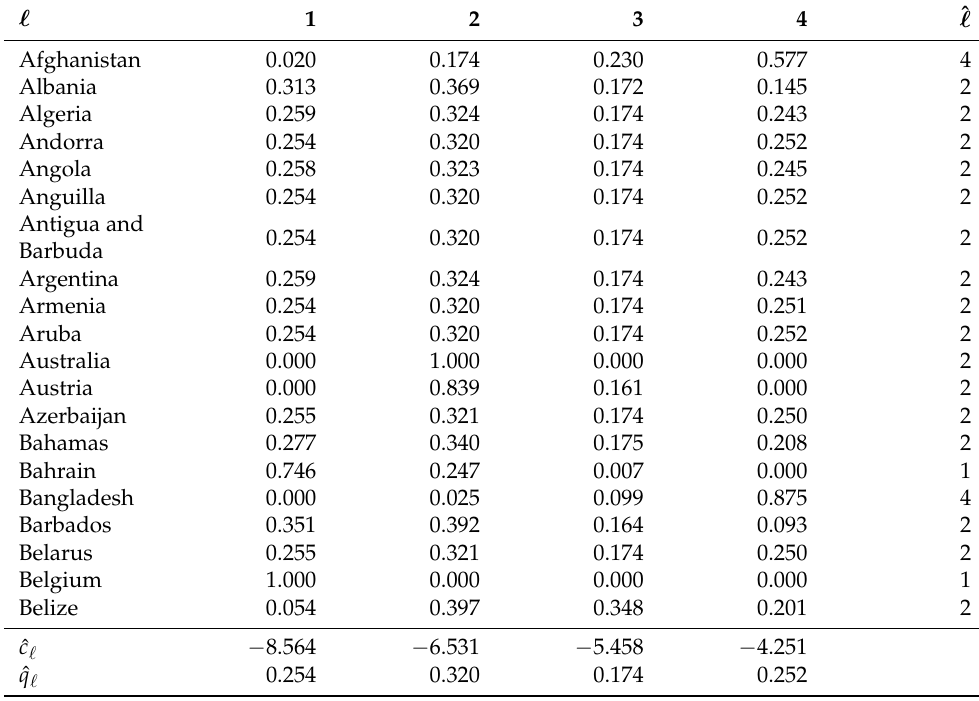
Table 4. Matrix V for data from 21 June 2022 using the 14-day lag, along with MAP classifications (right column) and the associated masses and mass points (bottom two